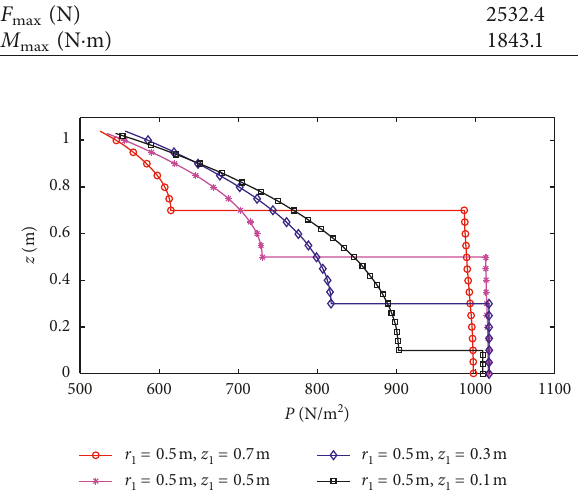
Figure 11: Wall-pressure distributions (at θ � 0) resulting in the maximum amplitudes F (a), 0.3m (b), 0.5m (c), and 0.7 m (d),